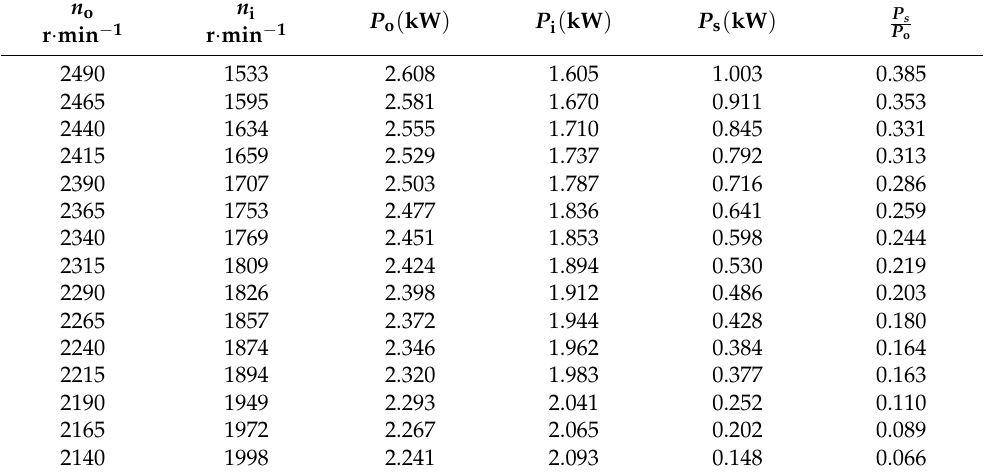
Table 3. Power of the coupler